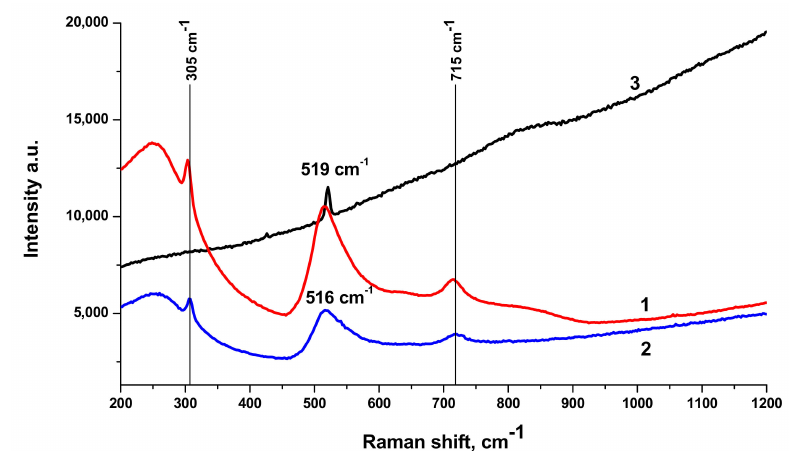
Figure 10. Raman spectra of: BTO NPs generated by laser ablation in H 2 O for 15 min (1), Au-BTO NPs generated by laser ablation of Au target in aqueous solution of BTO NPs for 10 min (corresponds to previous picture) (2), Au-BTO NPs generated by laser ablation of Au target in aqueous solution of BTO NPs for 15 min (corresponds to Figure 9) (3). Copied from reference [25] with copyright permission from Journal of Physics of Wave Phenomena Springer publisher.